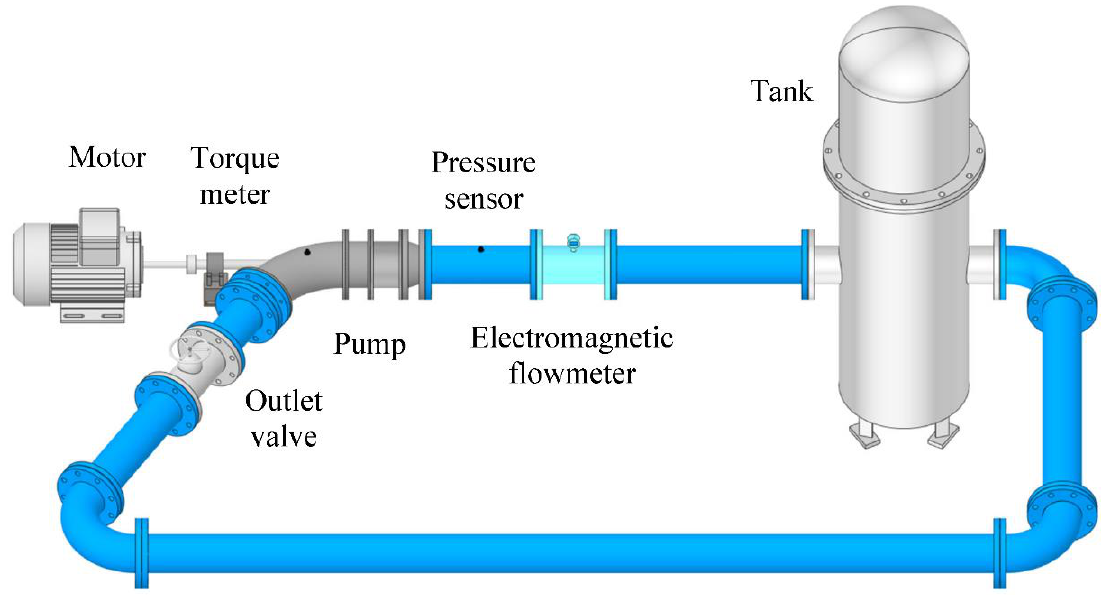
Figure 1. Test platform.